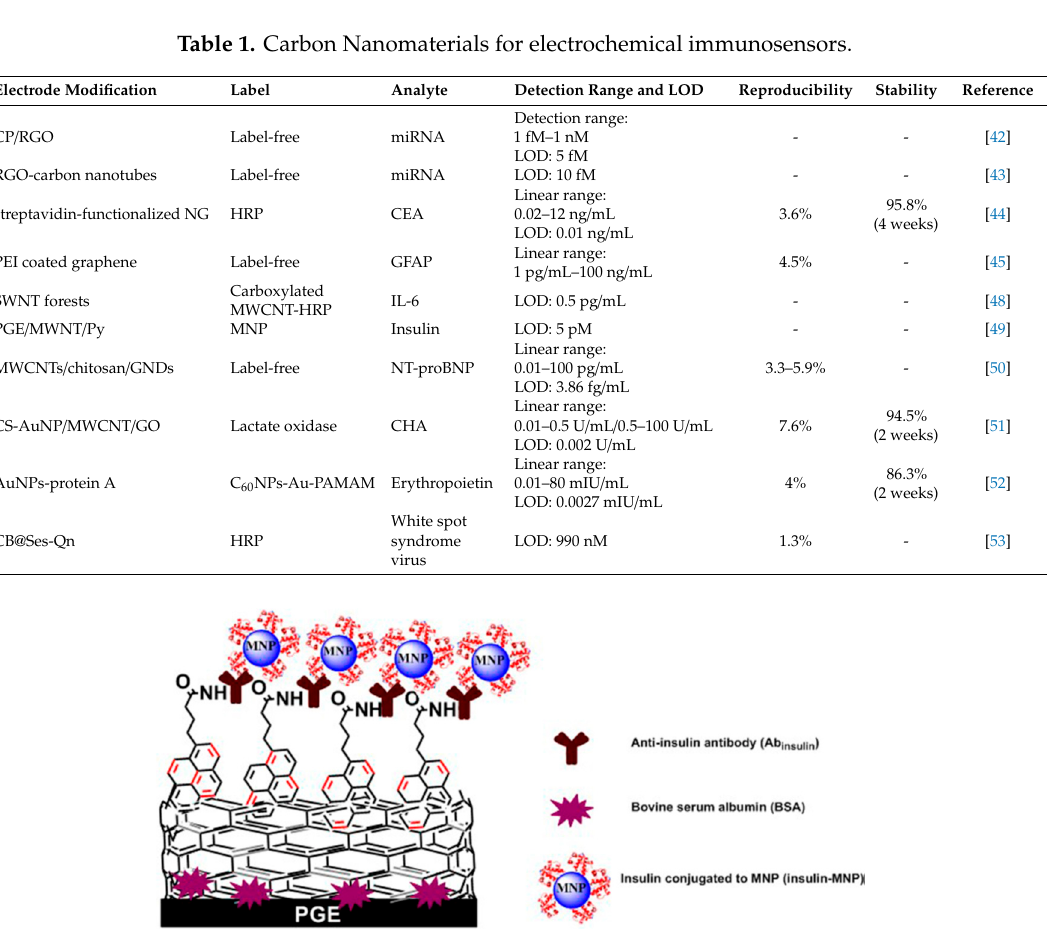
Figure 3. Schematic design of immunosensor for insulin detection in patient serum. Reproduced with permission from [49].